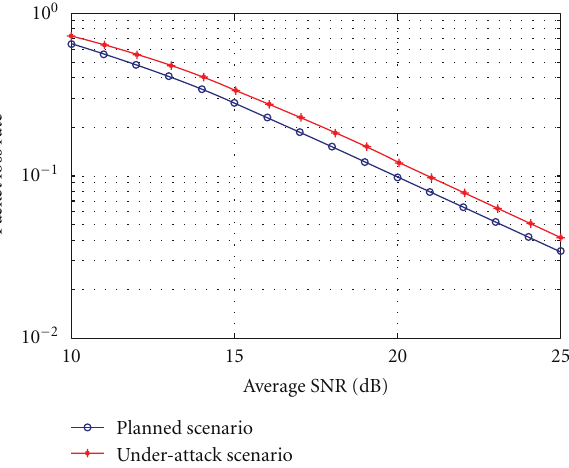
Figure 4: Global packet loss rate in di ff erent